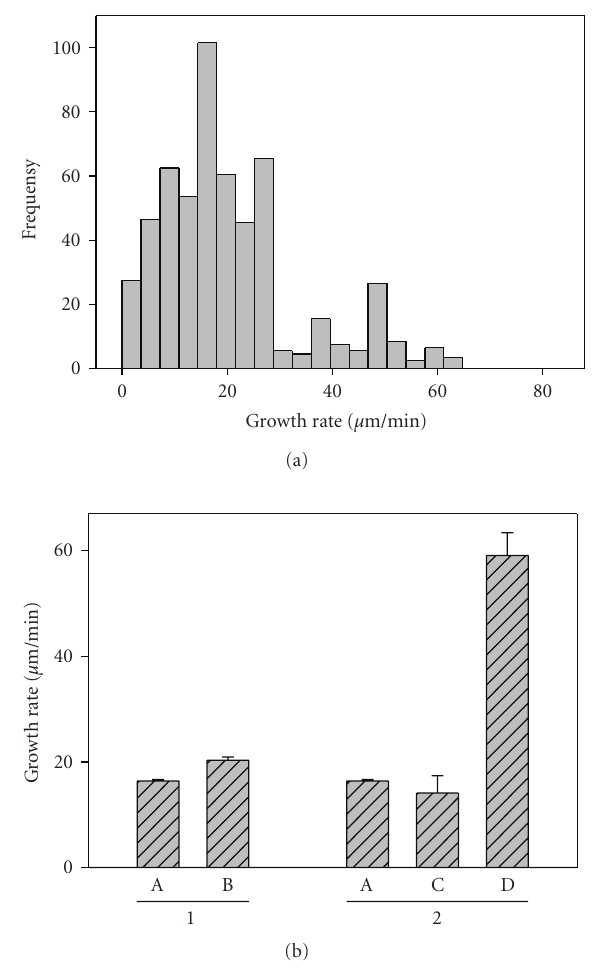
Figure 4: Microtubule plus-ends growth rate di ff erences in the centrosome region of single cells and cells growing in monolayer. Growing microtubule plus-ends were selectively marked in human EC. HPAEC were transfected with the plasmid expressing EB3-GFP. Persistent microtubule growth was confirmed by long EB3-GFP tracks. EB3-GFP movement was analyzed by time-lapse microscopy. Images were acquired every 1 second. Histogram of microtubule growth rate distribution was obtained by tracking EB3-GFP comets on microtubule tips growing radially from the centrosome region in single human EC (mean growth rate, 20 . 6 ± 0 . 6 μ m/min ( n = 72)) (a). Mean growth rates of microtubule plus-ends in the centrosome region of cells growing in monolayer (A) and in single cells (B); mean growth rates of “normal” (C) and “fast” (D) microtubule plus-ends in single cells